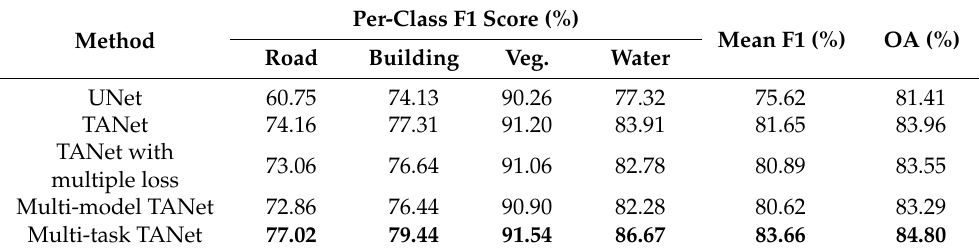
Table 6. F1 score, Mean F1, and OA index results of different models (CZ-WZ